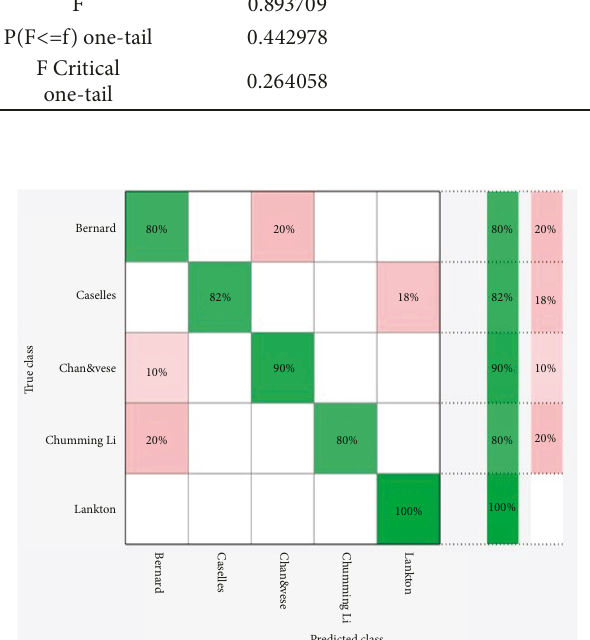
Figure 4: Confusion matrix of the classification of active contour segmentation